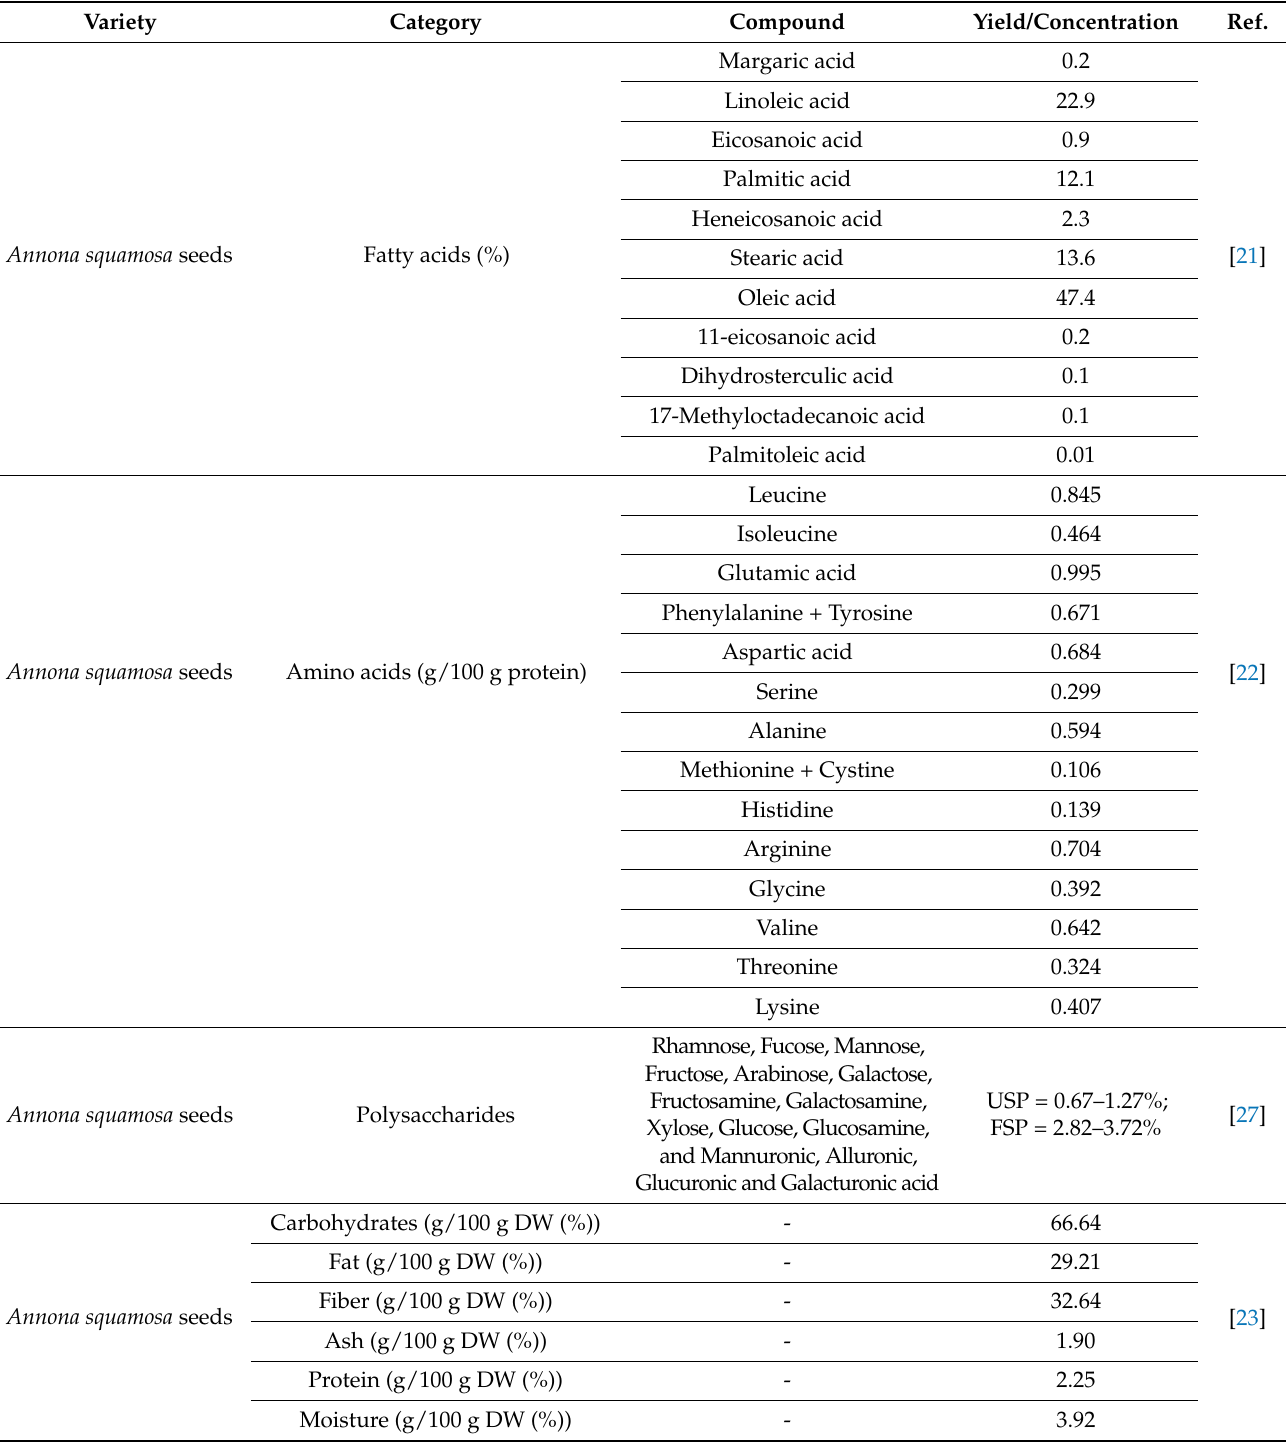
Table 1. Proximate composition of Annona squamosa